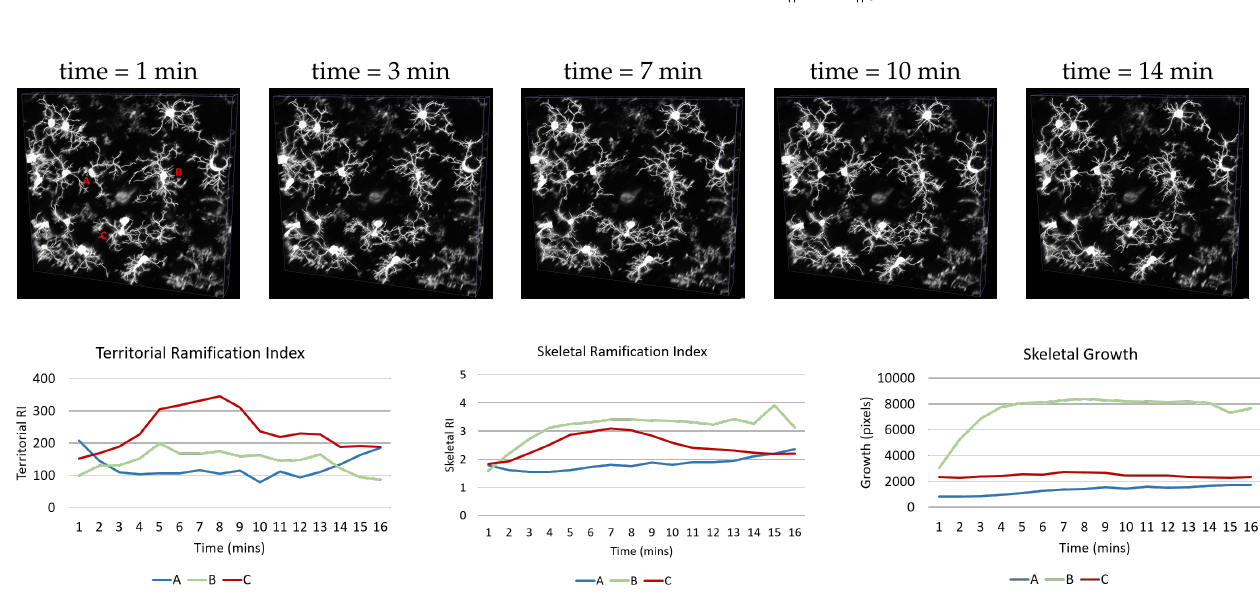
Figure 10. The top row frames of a video with microglia in motion after a laser burn induced injury, explained in Section 3.2. The video depicting the top row can be found in supplementary materials that is labeled SI4. The graphs show the associated measures over time for three microglia labeled in the first